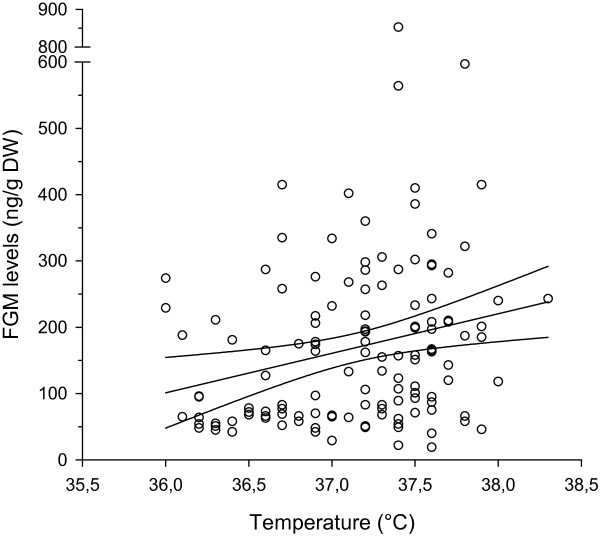
Relationship between FGM levels and body temperature (r = 0.238, n = 130, p = 0.006) determined in 26 pregnant Thoroughbred broodmares of > 7 months gestation, monitored up to seven times over a selected 19 day pre- to post-sale period.